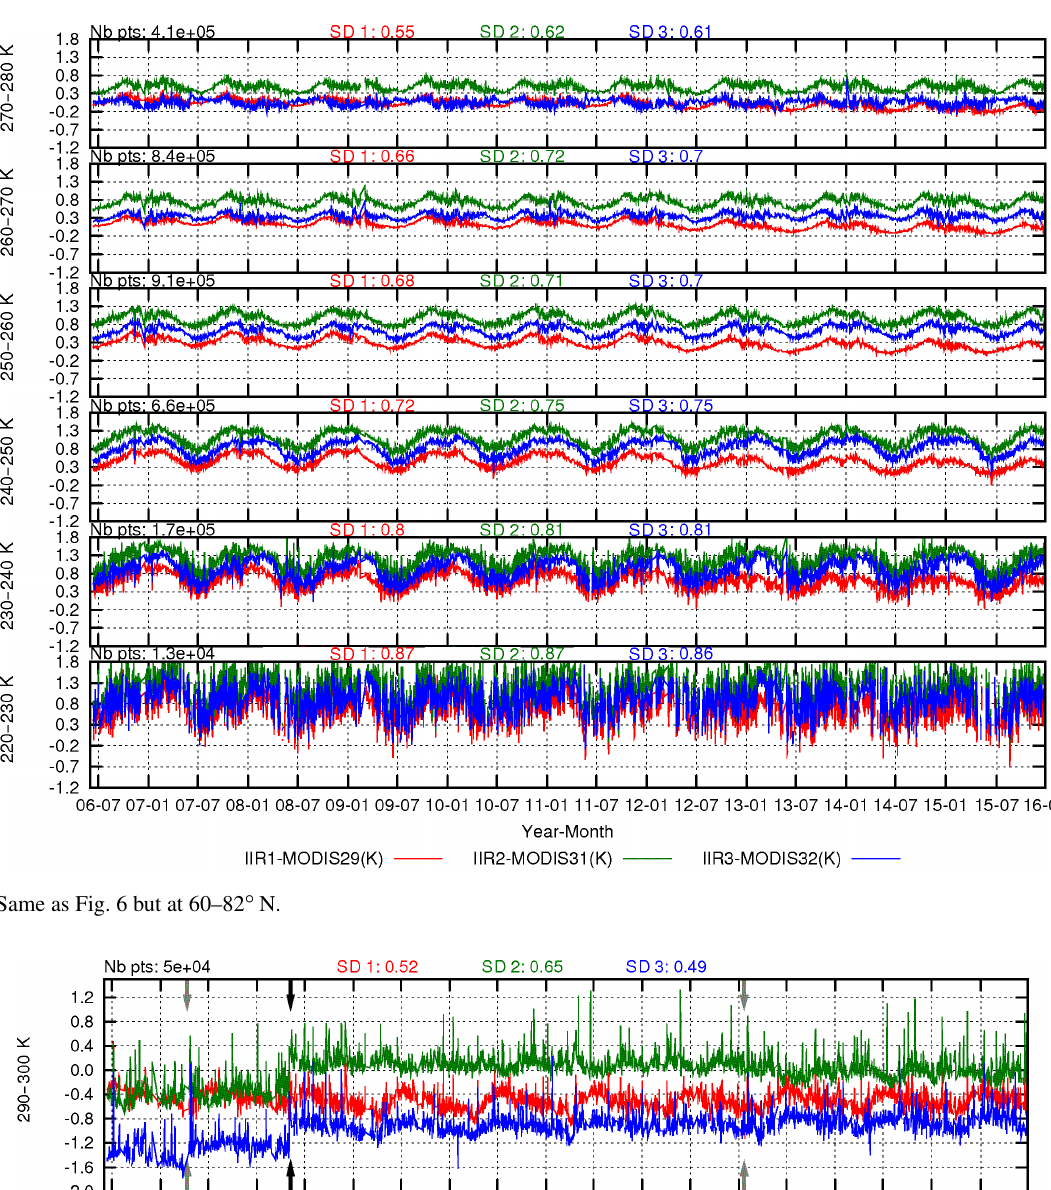
Figure 8. Time series ( x axis: year-month) of IIR–SEVIRI brightness temperature differences ( y -axis units: Kelvin) for the three pairs of companion channels (red: IIR1–SEVIRI8.7, green: IIR2–SEVIRI10.8, blue: IIR3–SEVIRI12) over ocean at 290–300K for SEVIRI viewing angles smaller than 10 ◦ . Added at the top of each panel are the mean number of points per day (Nb pts) and the mean standard deviation per day for each of the three pairs. The black arrows indicate the change in the definition of the SEVIRI product in May 2008. The grey arrows indicate the switch from Meteosat 8 to 9 in April 2007 and from Meteosat 9 to 10 in January